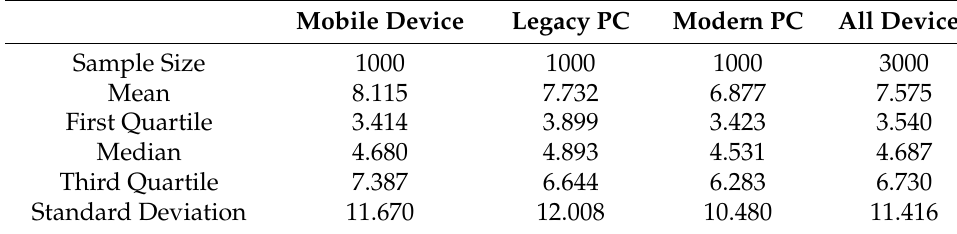
Table 3. Estimating the response time when answering question